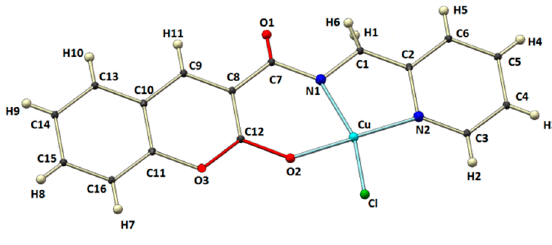
Figure 9. Single crystal structure of 2b -Cu 2 + .